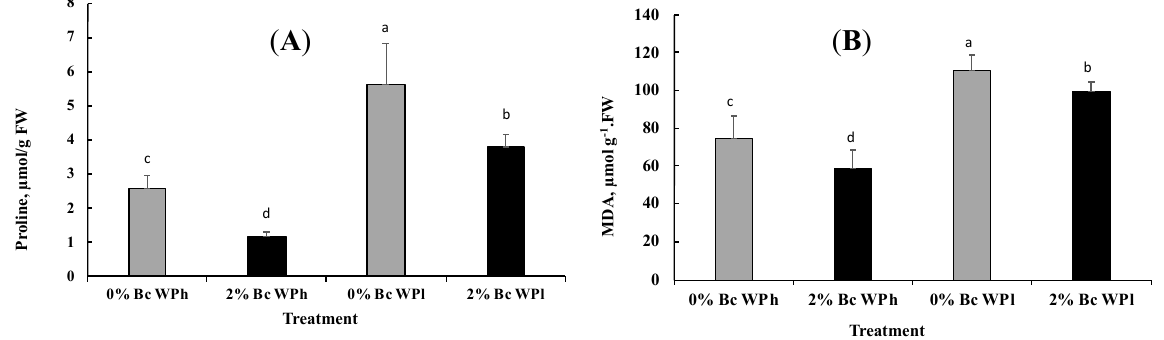
Figure 6. Changes in Proline ( A ) and MDA ( B ) content in Medicago ciliaris leaves after 3 weeks of drought treatment. Values represent mean ± SE ( n = 5) and the different letters a to d indicate significant differences between the treatments. Low soil water potential (WPl), high soil water potential (WPh), Biochar (Bc). Table 2. CO 2 /H 2 O gas exchange and chlorophyll fluorescence parameters (A net , V c , SC, C i /C a ratio, WUE, R L , R D , ETR, ETR/A gross and Y(NPQ)) of Medicago ciliaris leaves at a saturating light intensity after 3 weeks of drought treatment. Values represent mean ± SE ( n = 5) and different letters indicate significant differences between treatments. Net CO 2 assimilation rate (A net ) [ µ mol(CO 2 ) m –2 s –1 ], photosynthetic efficiency (V c ), stomatal conductance (S c ) [mol(H 2 O) m –2 s –1 ], ratio of intercellular and atmospheric CO 2 concentration (Ci/Ca ratio) [ µ mol(CO 2 ) m –2 s –1 ], ratio of net CO 2 assimilation rate and transpiration (A/E) ( µ mol/mmol), Photorespiration (R L ) ( µ mol(CO 2 )*m − 2 *s − 1 ), dark respi-